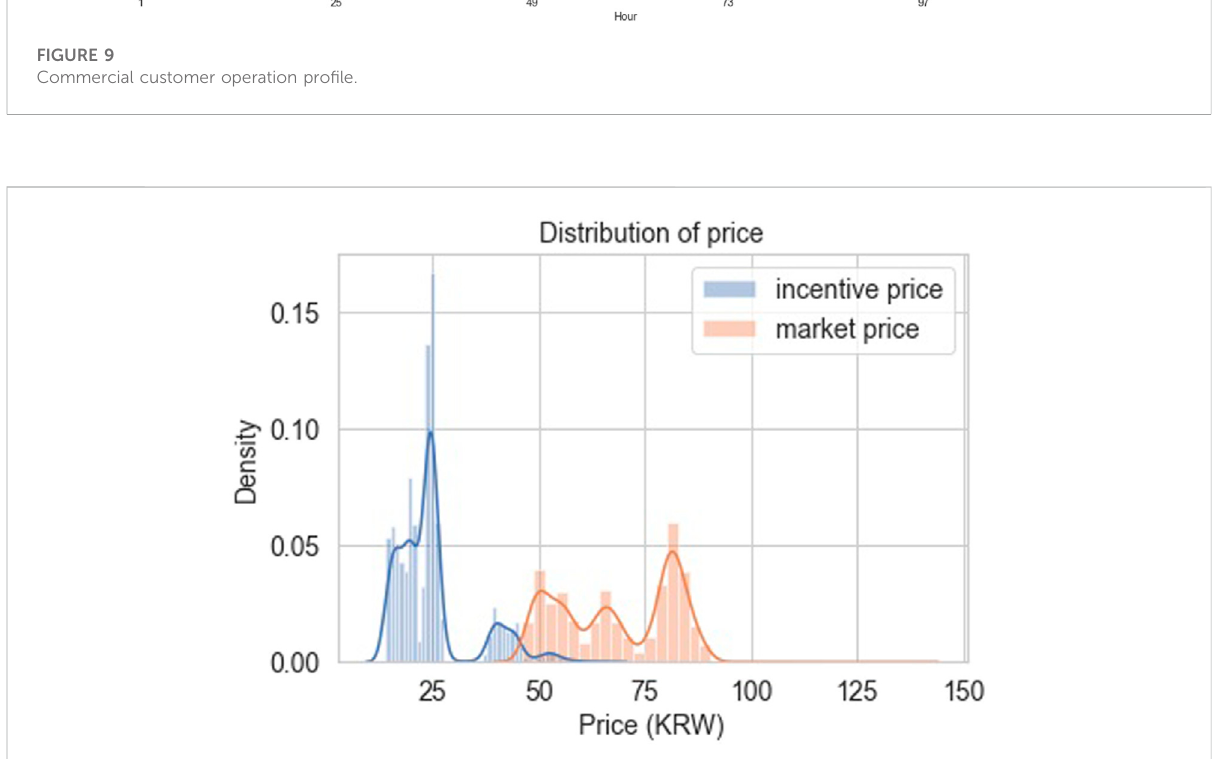
FIGURE 10 Probability distribution of the